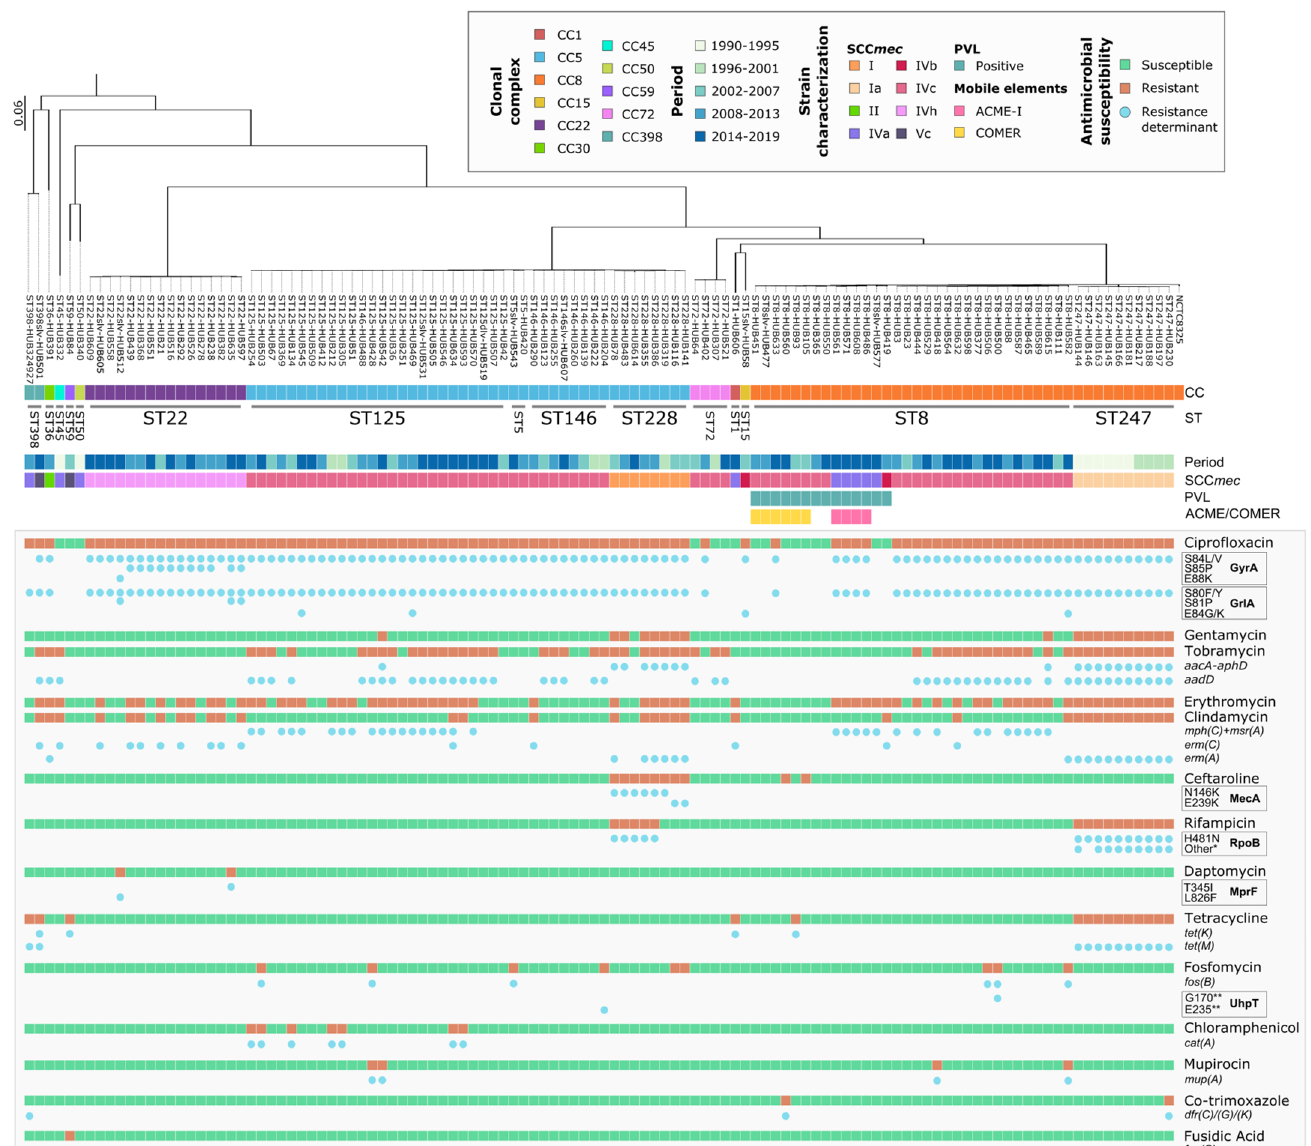
Figure 4. Assembly-based core SNP phylogenetic tree, period, clonal complex, antibiotic resistance, and associated molecular mechanisms. The coloured bars indicate the period and the strain characteristics (CC, SCC mec, PVL, and ACME/COMER elements). In the grey-shaded area, the coloured squares represent the antimicrobial resistance (in red) and susceptibility (in green) by antibiotic group and following CLSI breakpoints [25], followed by blue circles when a resistance determinant was detected. * Other alterations of RpoB, D471G/Y, and S529L. ** Indicates a STOP codon. CC, clonal complex; ST, sequence type; SCC mec , staphylococcal chromosomal cassette mec ; PVL, Panton-Valentine leukocidin; ACME, arginine catabolic mobile element; COMER, copper and mercury resistance mobile element.